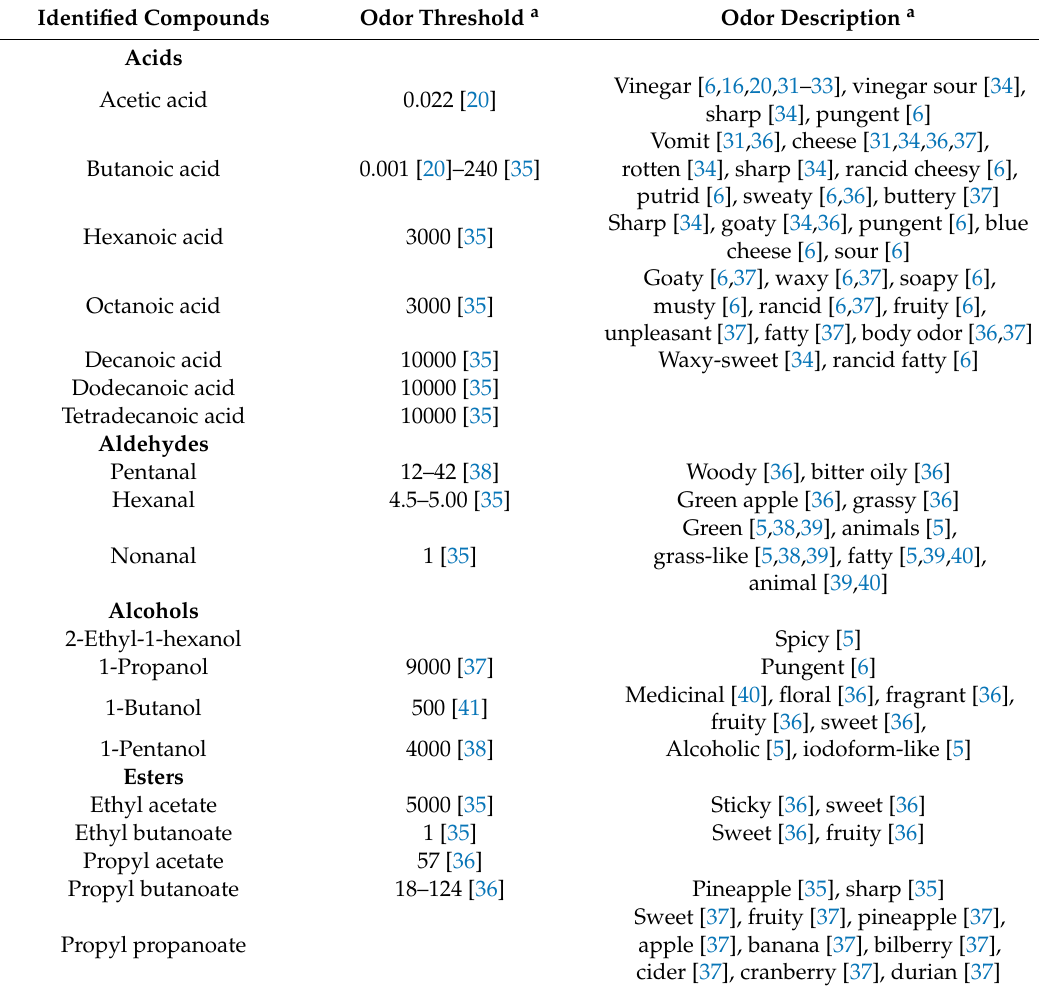
Table 4. Odor description and odor threshold in water ( µ g kg − 1 ) of the identified volatile organic compounds in the assessed milk and mozzarella